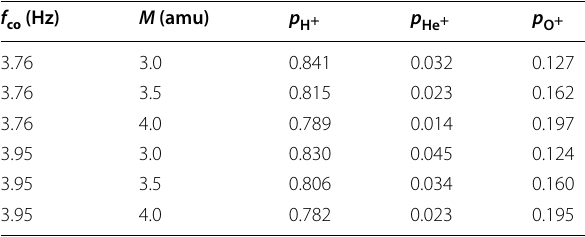
Table 1 Solution of p H + , p He + , and p O + for different values of f and co